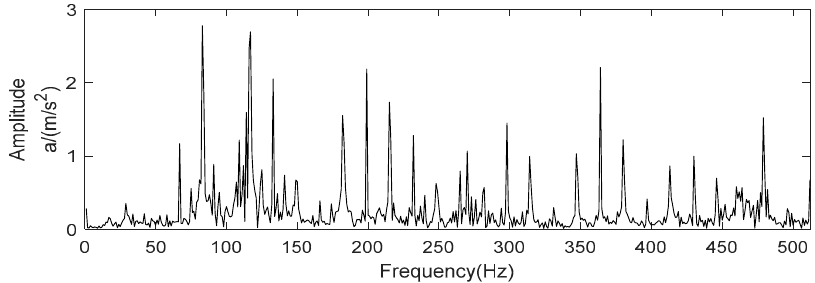
Figure 18. The amplitude spectrum of the fan gearbox vibration acceleration signal.